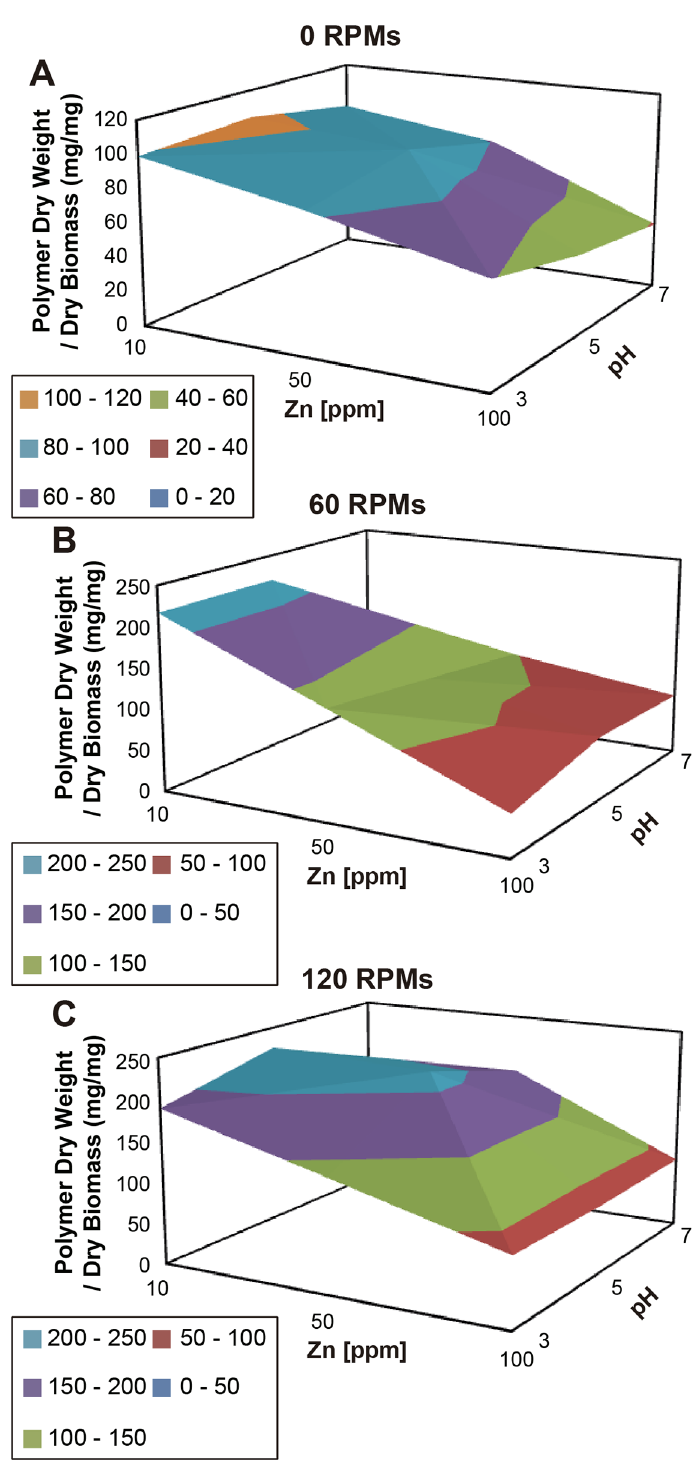
Fig 8. Effect of Agitation Speed, pH and Metal Concentration on Exopolysaccharide Production (mg) per Amount of Biomass (g), after growing 106 h, by Rhodotorula mucilaginosa strain UANL-001L. Dry weight exopolysaccharide (g) produced per amount of biomass (g) after grown for 106 h at low, medium and high levels of pH and metal concentration and keeping Rpm constant at A) 0, B) 60 and C) 120.